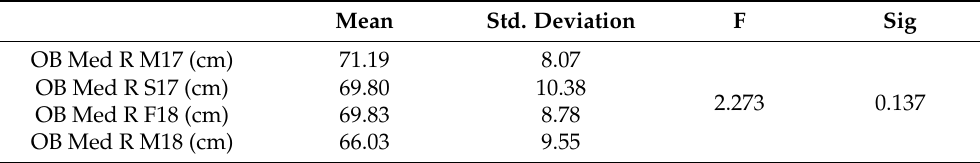
Table 4. OB values in the medial direction of the right arm. Mean Std. Deviation F Sig